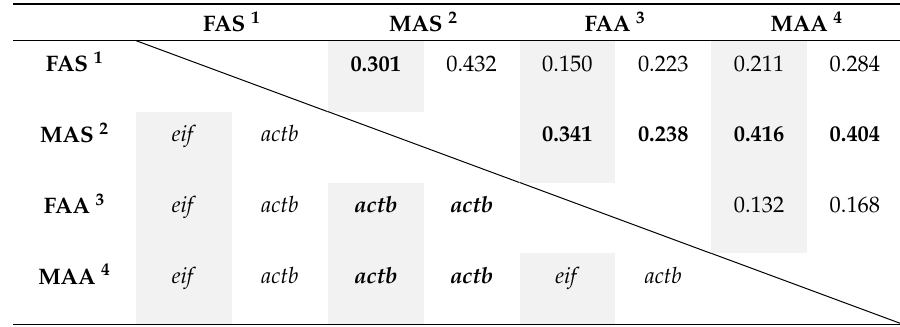
Selection output of the most stable candidate reference genes under di ff erent sample